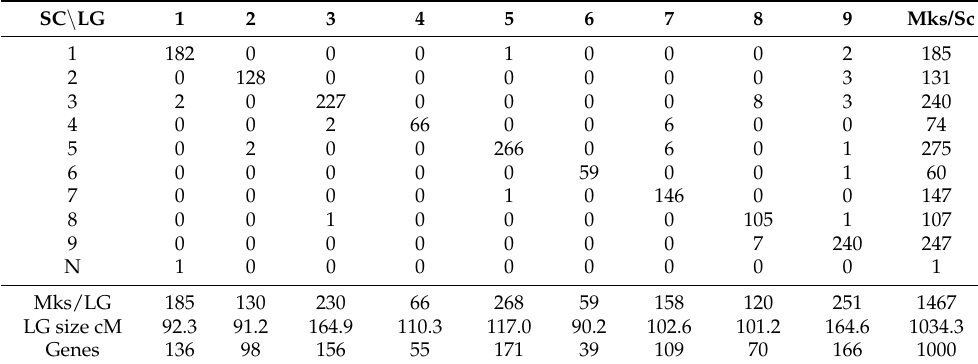
Table 2. Summary of ‘Ellendale’ tangor mapping